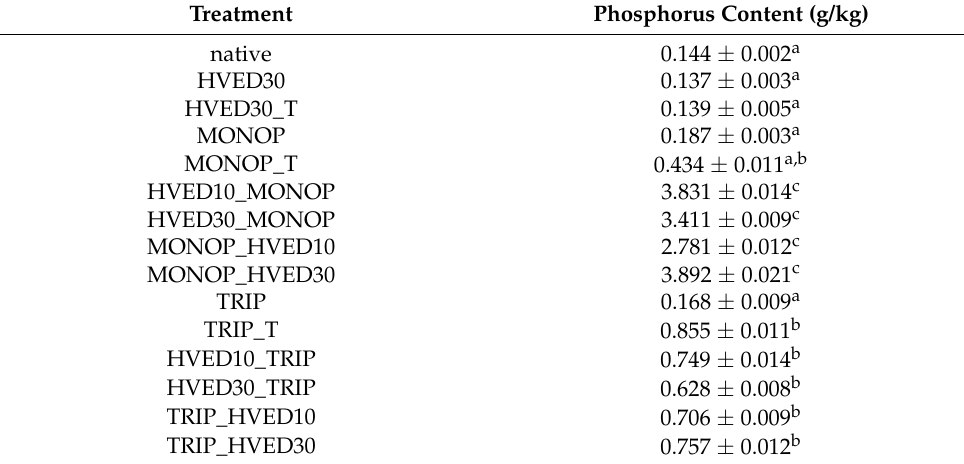
Table 1. Phosphorus content in native and modified maize starches (HVED10 = 10 min treatment with HVED; HVED30 = 30 min treatment with HVED; MONOP = Na 2 HPO 4 ; TRIP = Na 5 P 3 O 10 ; T = thermal